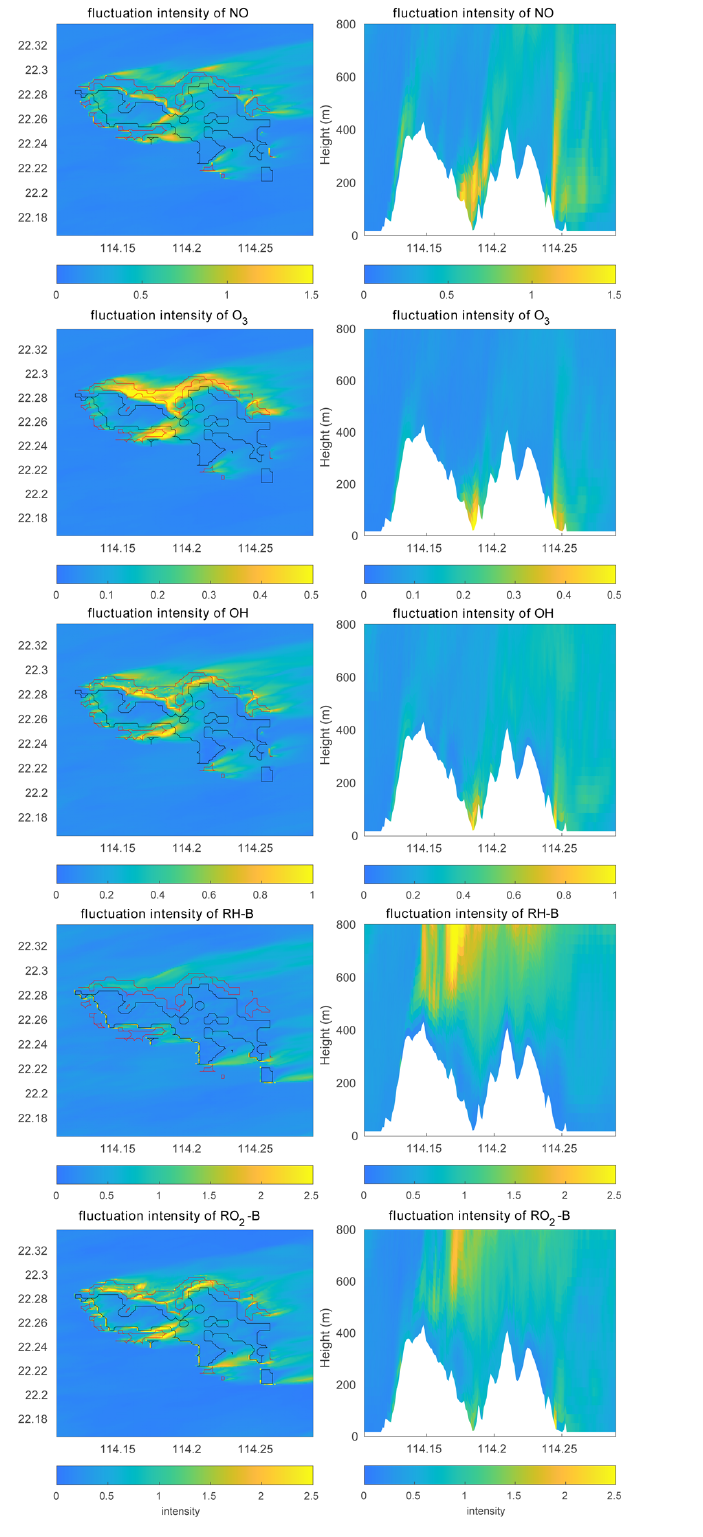
Figure 11. Concentration fluctuation intensities (variance divided by the mean concentration) at the first level (left panels) and the vertical cross section along latitude 22.275 ◦ N (right panels) at hour 4 for TERW case. The red line shows the urban area, and the black line shows the forest